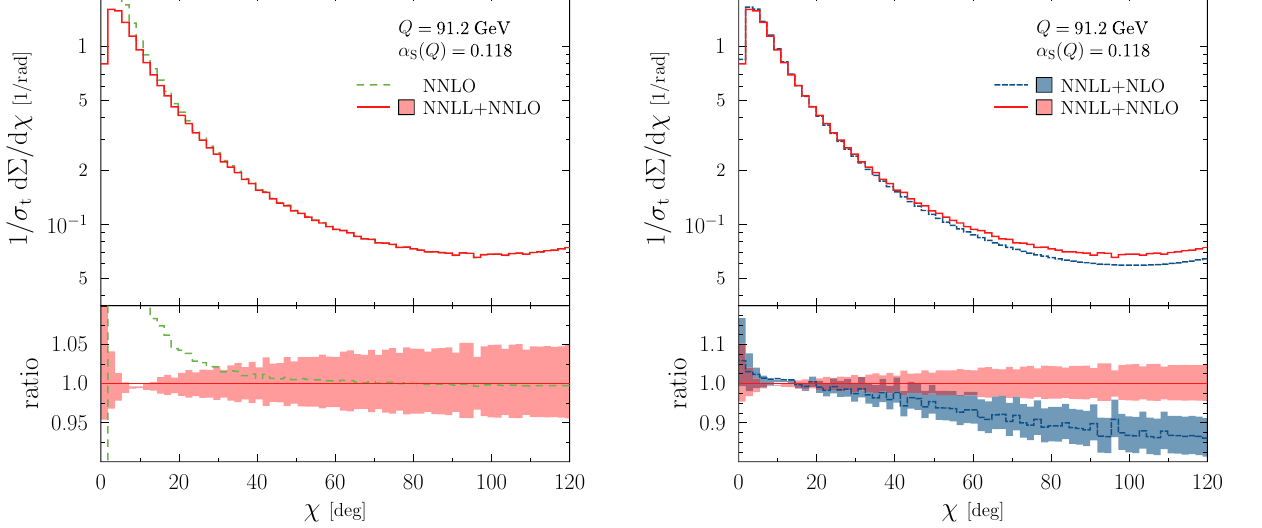
Fig. 4 NNLL + NNLO matchedprediction for EEC. The bottom panel shows the ratio of the fixed-order NNLO prediction to the matched result. The band represents renormalization scale variation of the matchedpredictionintherange μ ∈ [ Q / 2 , 2 Q ] withthree-looprunning of α S